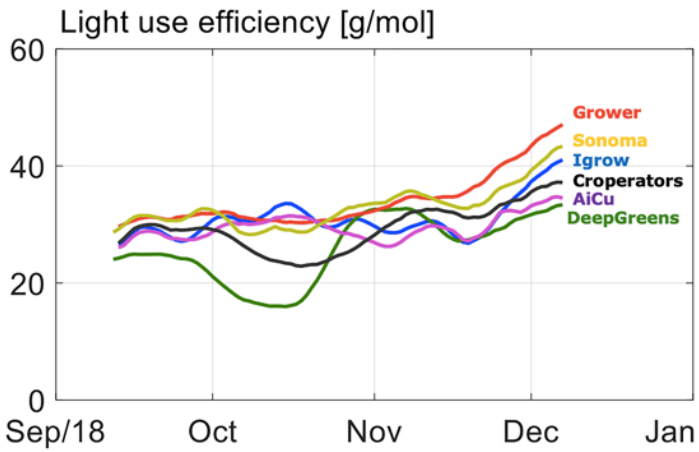
Figure 6. Course of light use efficiency in g cucumber per mol total daily light integral in different compartments.